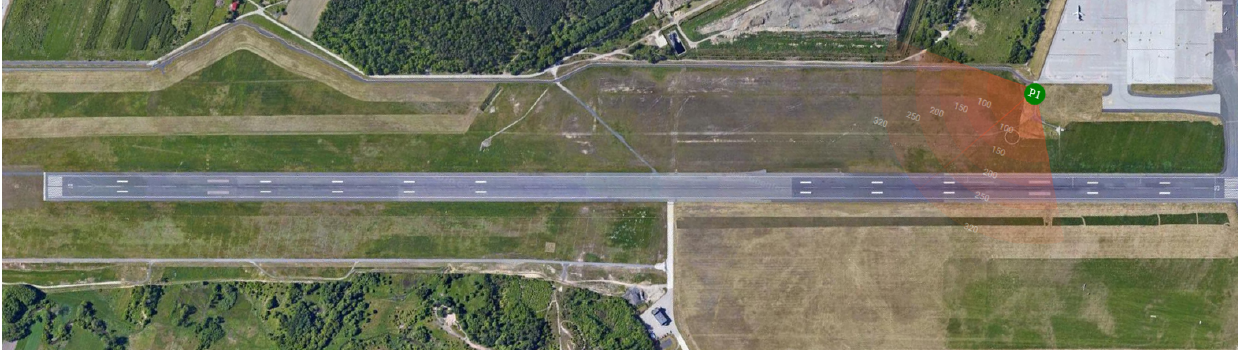
Figure 12. The installation spot depicted as P1 at the airport.